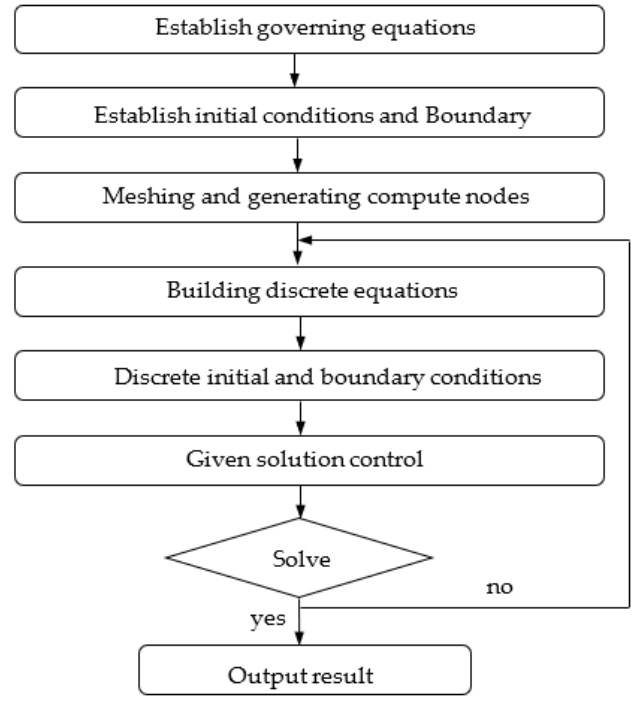
Figure 5. CFD workflow